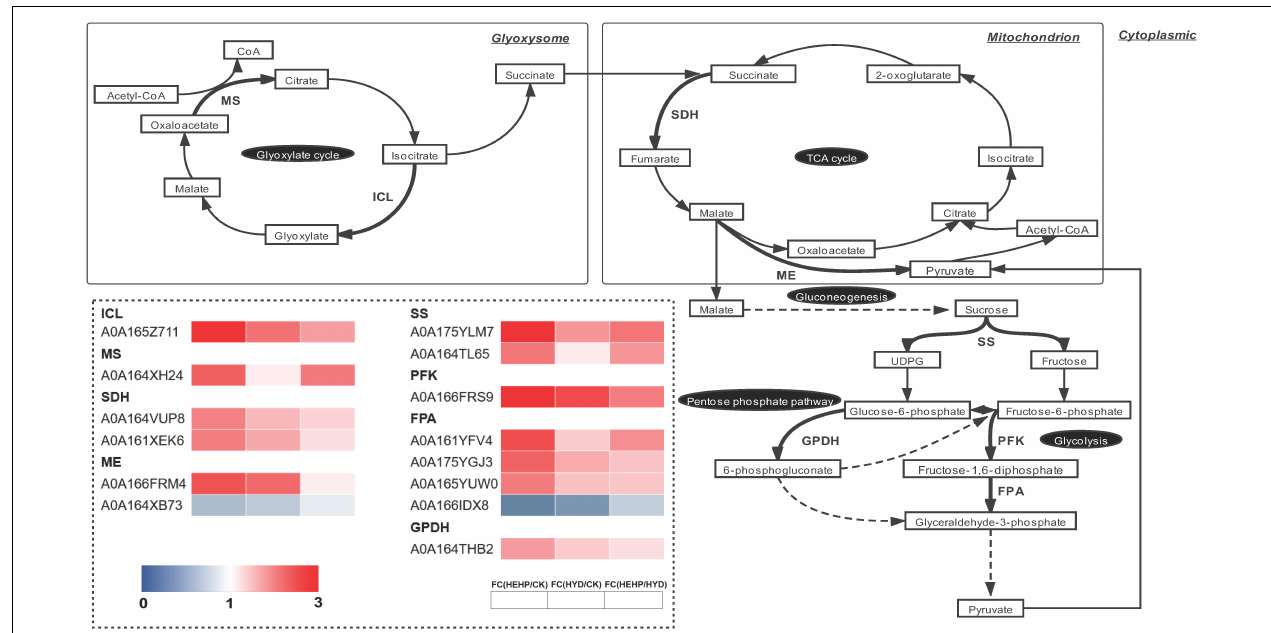
FIGURE 6 | Differentially abundant proteins involved in the glyoxylate cycle and respiratory metabolism. ICL, isocitrate lyase; MS, malate synthase; SDH, succinate dehydrogenase; ME, malic enzyme; SS, sucrose synthase; PFK, 6-phosphofructokinase; FPA, fructose-bisphosphate aldolase; GPDH, glucose 6-phosphate